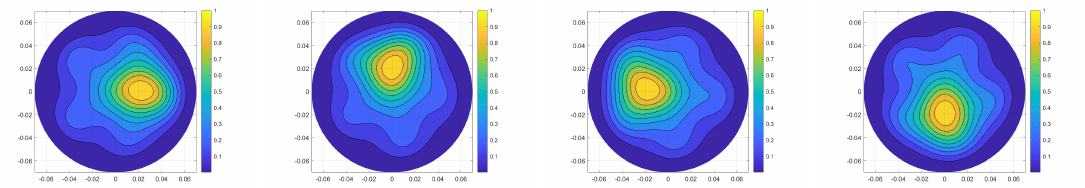
Figure 2. Ideal image generated by subtracting data of the phantom with no inclusion from the one with an inclusion (positioned at 0 ◦ , 90 ◦ , 180 ◦ and 270 ◦ ),